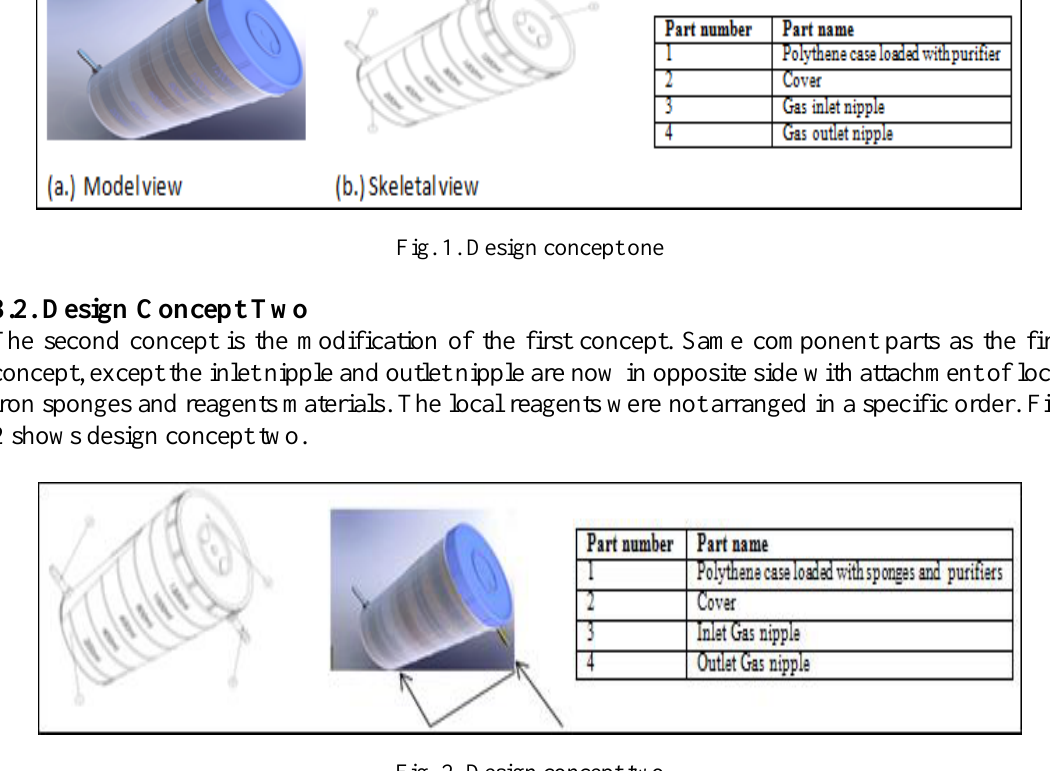
Fig. 2. Design concept